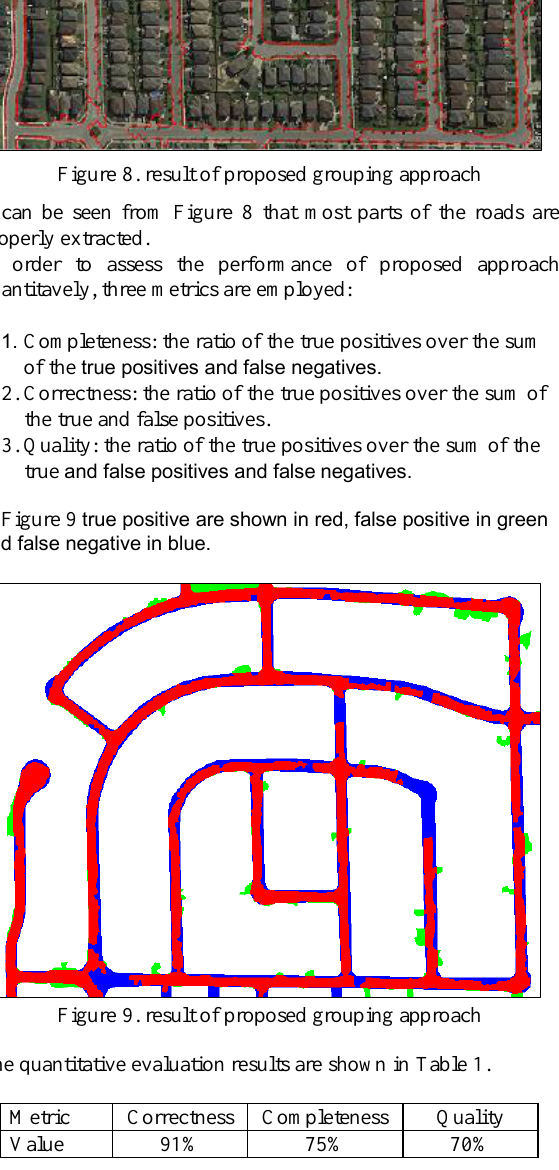
Table 1. Quantitative evaluation results in terms of the three evaluation metrics: completeness, correctness, and quality As it can be seen from Table 1, the correctness of approach extracted is high. However some road segments are missing. Missing parts are mostly due to the lack of the object markers near those segments or because of a misclassification of initial